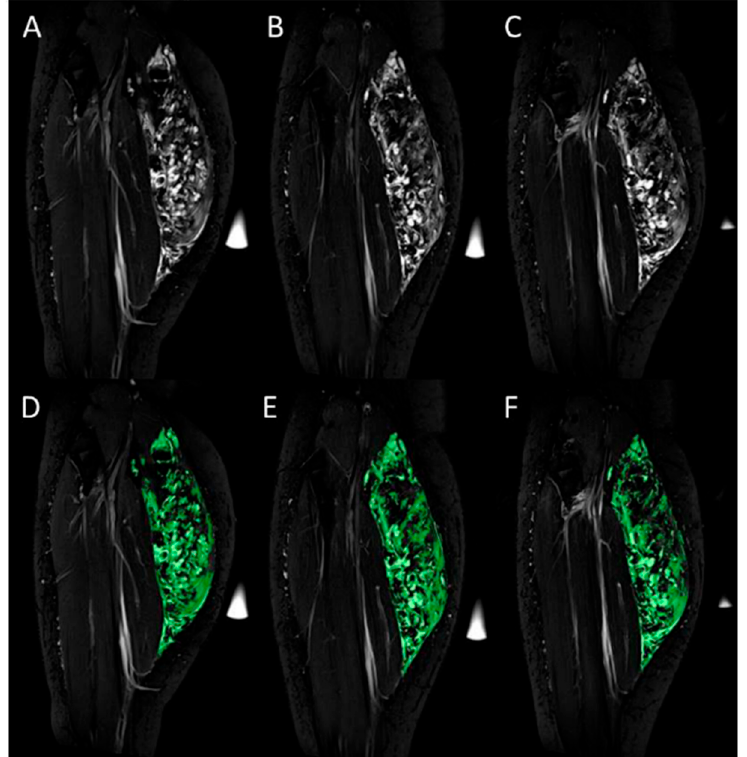
Figure 2. Volume of venous malformations was assessed in the T2-weighted TIRM images acquired without ( A , D ) and with wearing compression stockings of class I ( B , E ) and class II ( C , F ). Exemplary images before ( A – C ) and after color-coded manual segmentation of the venous malformation within the medial head of the gastrocnemius muscle are shown ( D – F